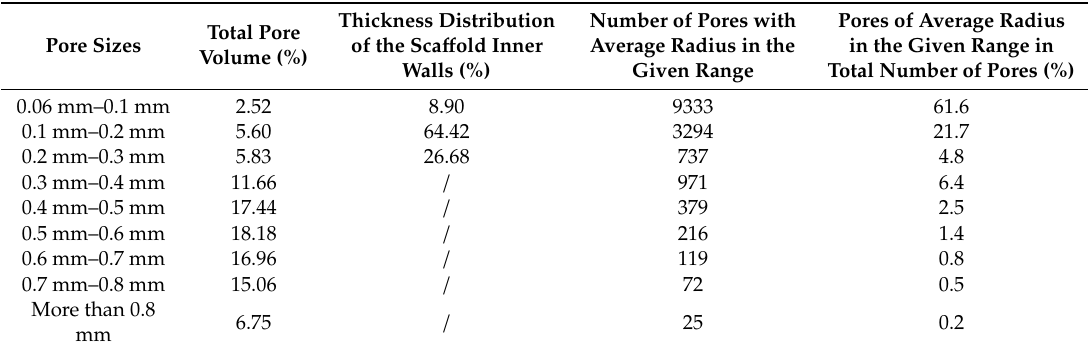
Table A1. Values of ALBO-OS